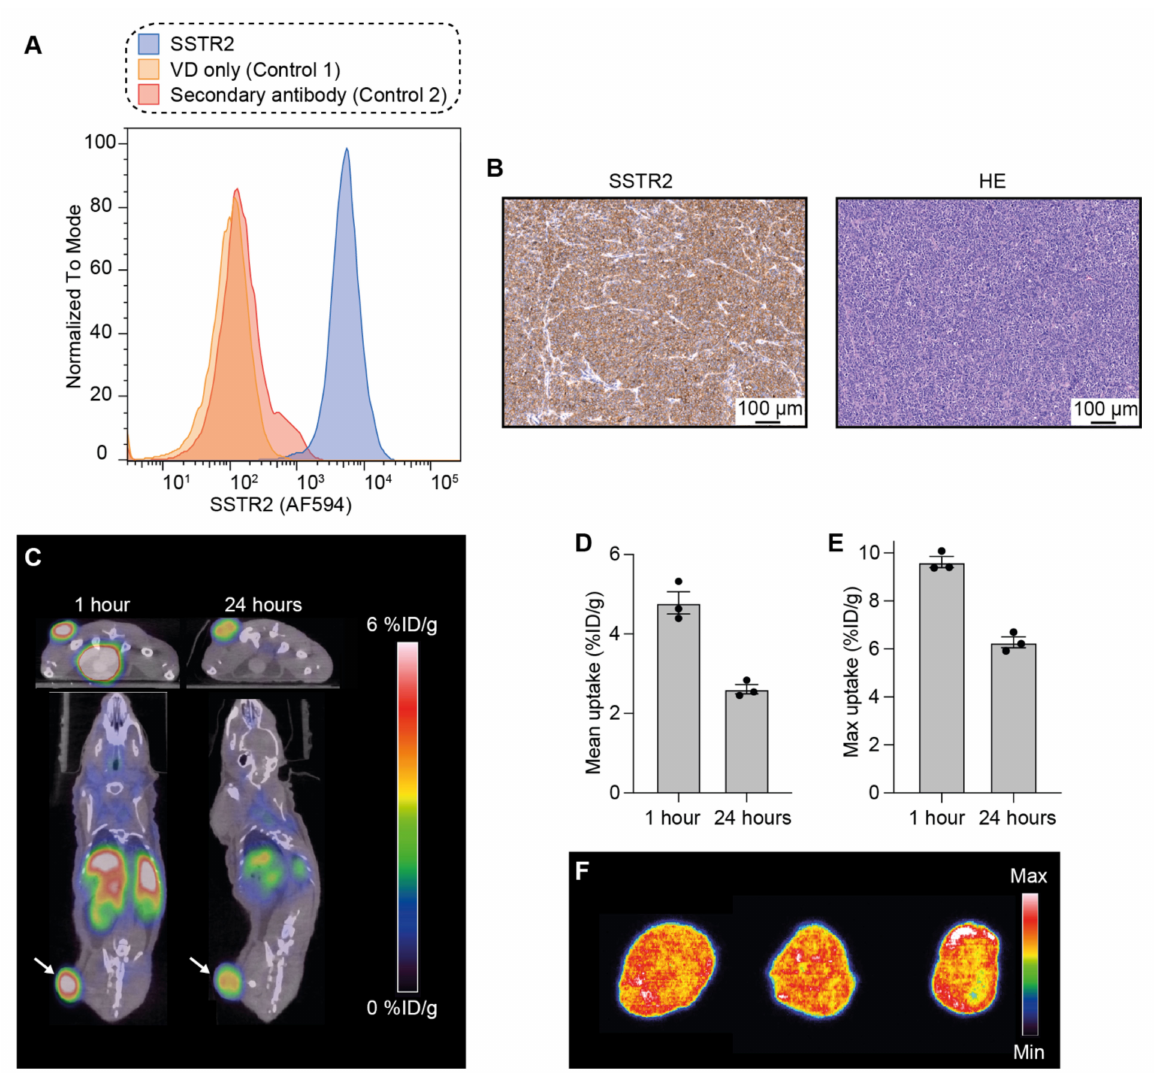
Figure 1. SSTR2 expression and [ 64 Cu]Cu-DOTA-TATE tumor uptake in the NCI-H69 model. ( A ) Flow cytometric analysis of NCI-H69 cells to confirm SSTR2 expression (in triplicates). VD = viabil- ity dye. ( B ) Histological analysis to detect SSTR2 expression in NCI-H69 tumors and HE staining. ( C ) Representative PET/CT images of mice to observe [ 64 Cu]Cu-DOTA-TATE distribution 1 h and 24 h after injection. Arrows point to the tumors. ( D , E ) Mean ( D ) and maximum ( E ) [ 64 Cu]Cu-DOTA-TATE uptake in the tumor presented as percentage of injected dose per gram of tissue (% ID/g) 1 h and 24 h after injection. Data shown as mean ± standard error of the mean (SEM; n = 3). ( F ) Autoradiography of the [ 64 Cu]Cu-DOTA-TATE tumor distribution (each tissue slice belongs to a different